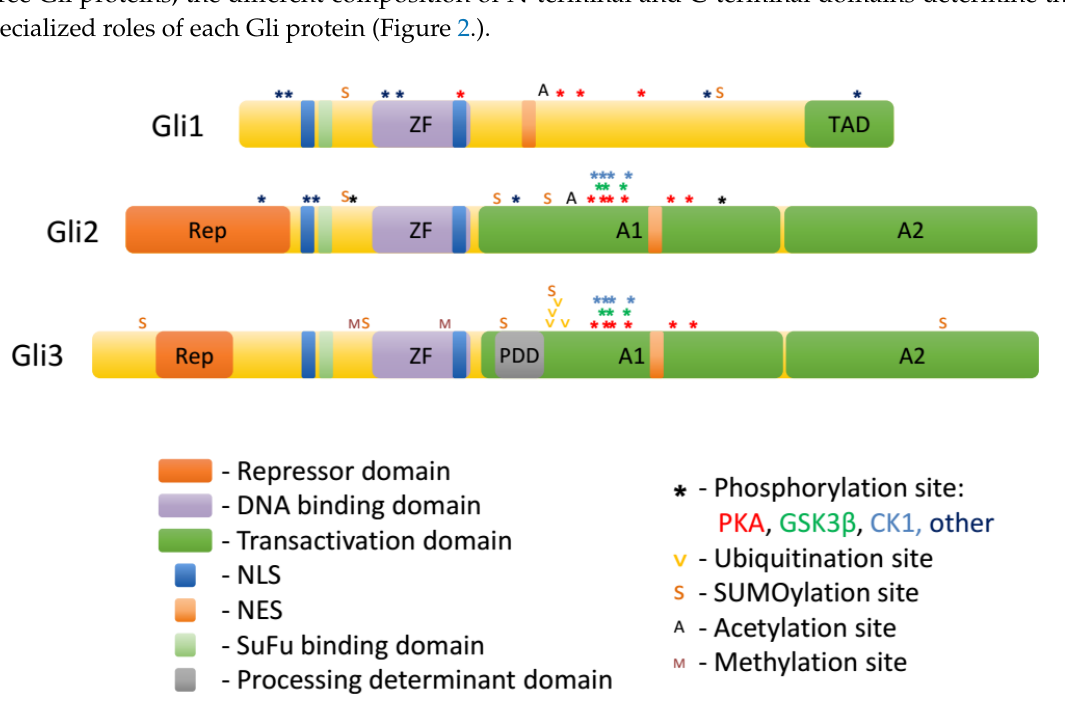
Figure 2. Domains and posttranslational modifications of Gli proteins.